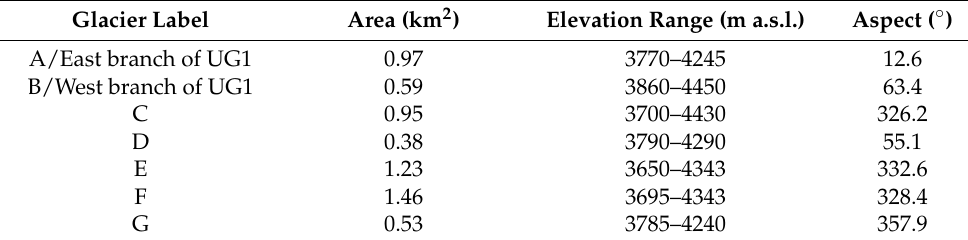
Table 1. Overview of all seven study glaciers, including their area, elevation range, and mean aspect. UG1, Urumqi Glacier No. 1. The elevation range and mean aspect for each glacier were extracted from ASTER GDEM V2 with a 30 m spatial resolution (downloaded from http://earthexplorer.usgs.gov/, accessed on 1 March 2021). The aspect of the glacier matched the average aspect of the area of the glacier. Glacier Label Area (km 2 ) Elevation Range (m